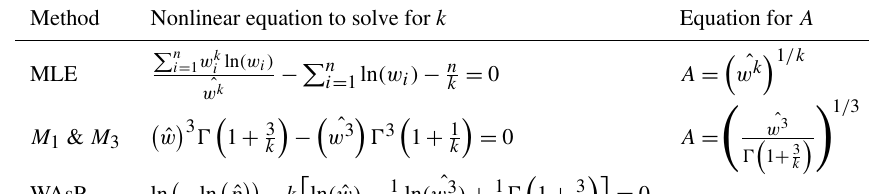
Table 1. Sets of equations used to fit the Weibull distribution for each method (see text for notations). Method Nonlinear equation to solve for k Equation for A